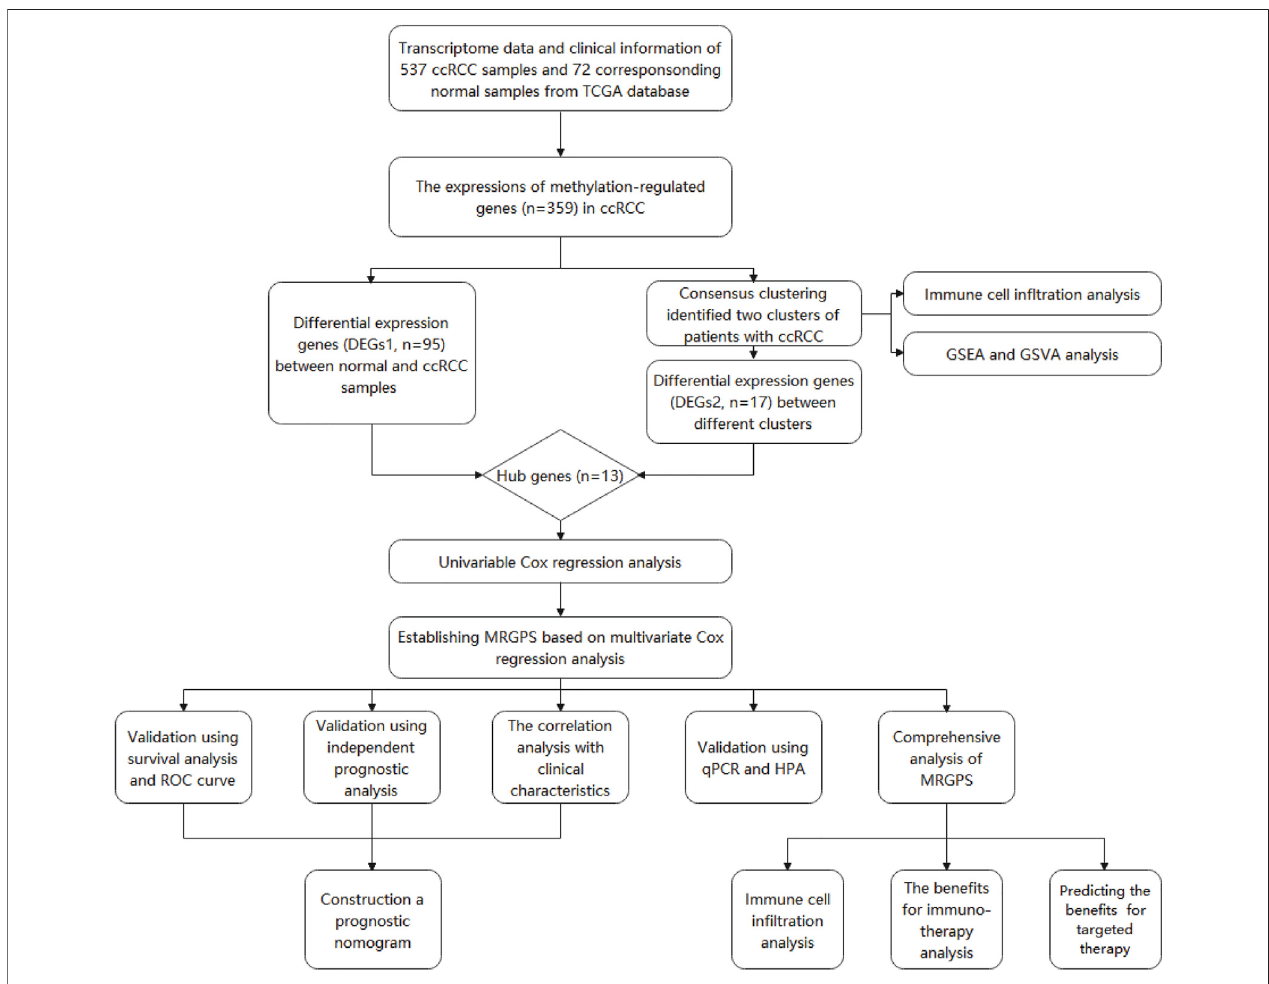
FIGURE 1 | The entire analytical process of the